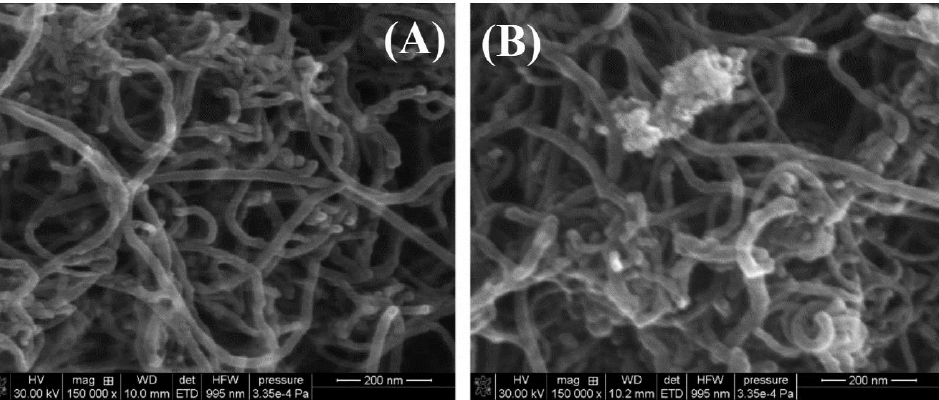
Figure 2. SEM image of ( A ), MWCNTs – CO 2 H and ( B ), BI@MWCNTs.